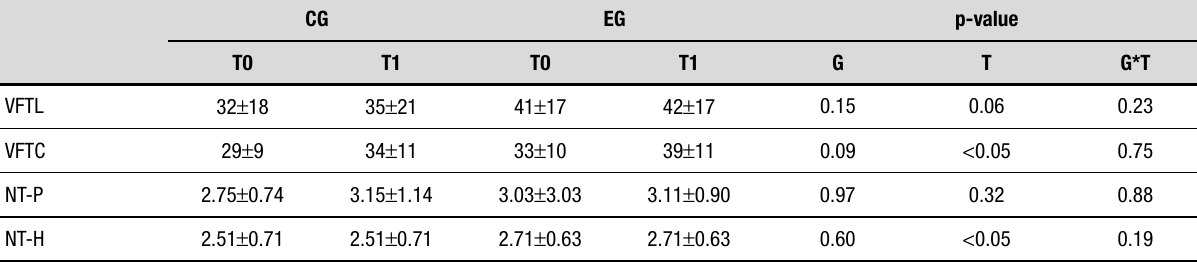
Table 2. Effects of memory training on verbal fluency and NeuroTracker over time, for the effect of group, time and group.